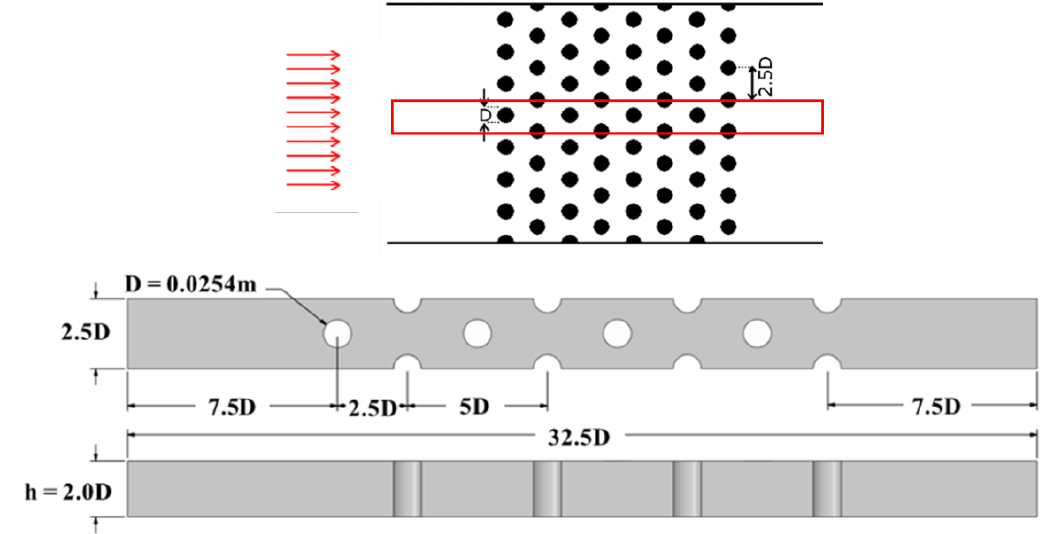
Figure 1. Computational domain of geometry.